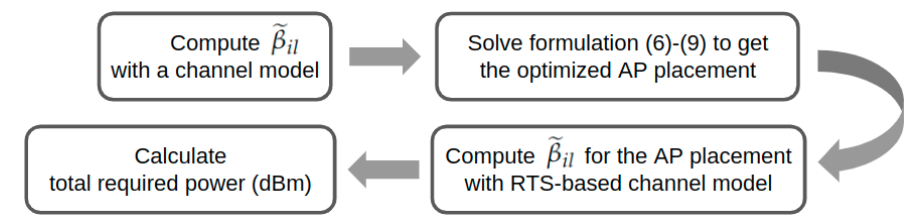
Figure 7. The procedure for executing the experiments with different channel